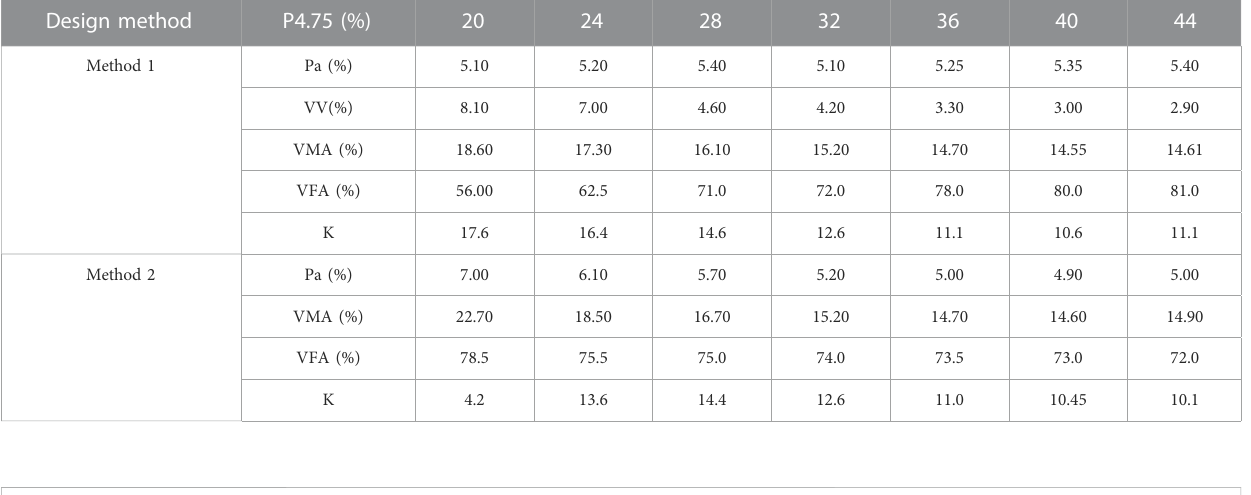
TABLE 9 Parameters for different design methods.